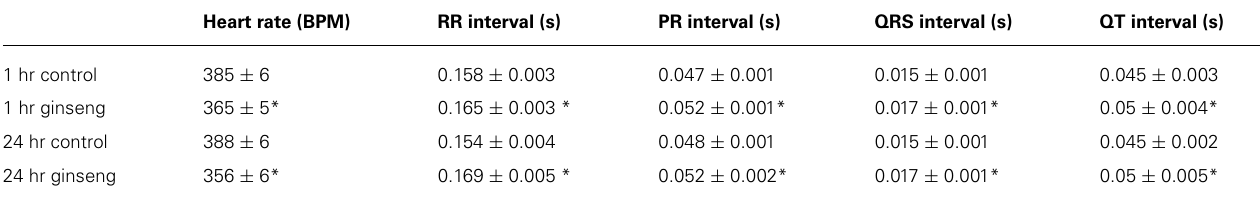
Table 1 | ECG data from control and 1 and 24 h water ginseng treated rats.